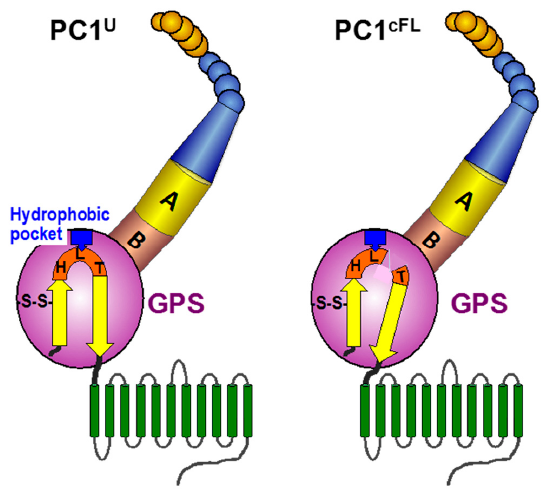
Figure 2. Schematic depiction of the GAIN domain in uncleaved (PC1 U ) and cleaved heterodimeric (PC1 cFL ) forms of polycystin-1. The model is based on an analogy with the structure of the GAIN domains of the adhesion GPCRs. A, GAIN subdomain A; B, GAIN subdomain B. In PC1 cFL , the tight association of the last β -strand harnesses the cleavage-released force to generate a small tilt. The disulfide bridge (-S-S-) at the penultimate β -strand is shown. The trapping of the Leu (L) side chain of the HLT tripeptide within a conserved hydrophobic pocket is depicted by a blue box. The color code of the structural elements is identical as in Figure 1.